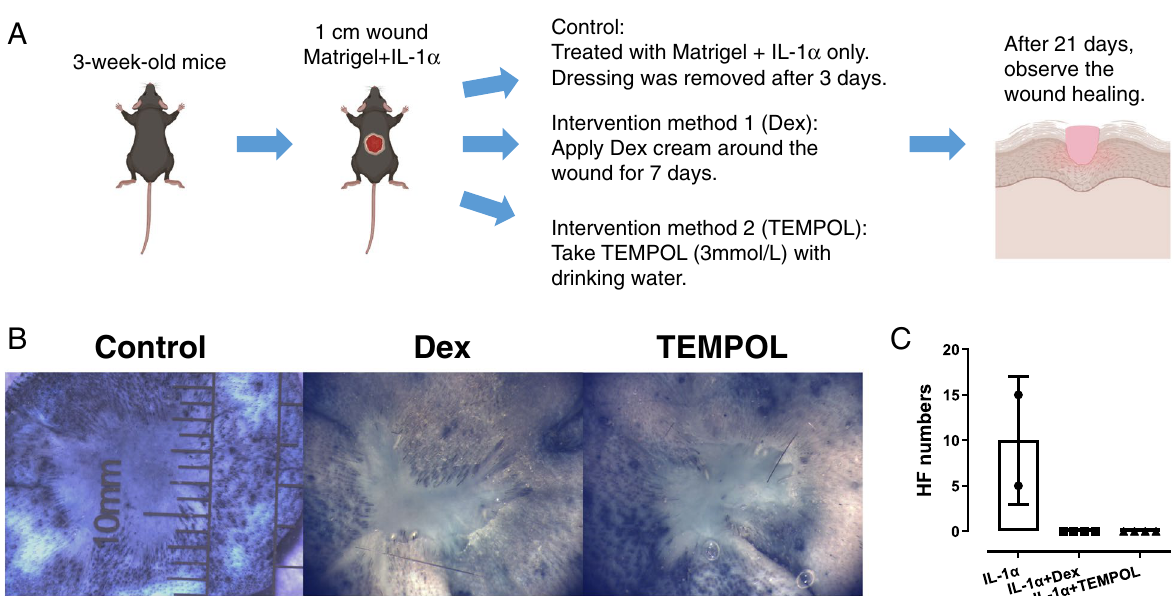
Fig. 6 IL-1α induces de novo HFs regeneration by regulating inflammation and ROS productions. A Experimental steps. B , C Dexamethasone and TEMPOL inhibited the effects of IL-1α. Dex,